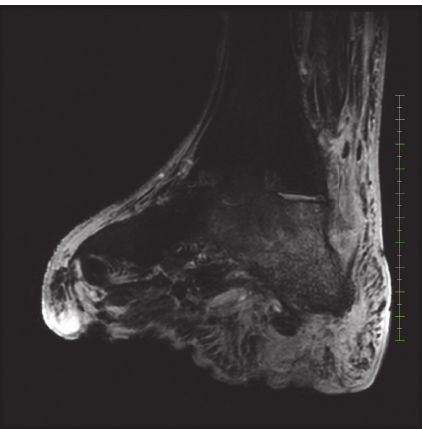
Figure 1: Magnetic Resonance Imaging demonstrating chronic osteomyelitis of the right calcaneus.